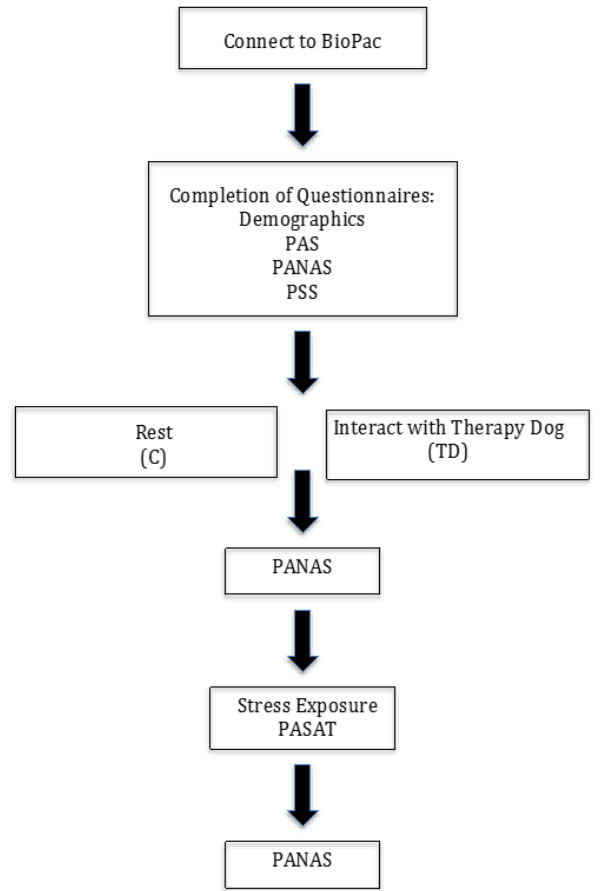
Figure 1. Flowchart of the study procedure. PAS: Pet Attitude Scale; PANAS: Positive and Negative Affect Scale; PASAT: Paced Auditory Serial Attention Task; PSS: Perceived Stress Scale.